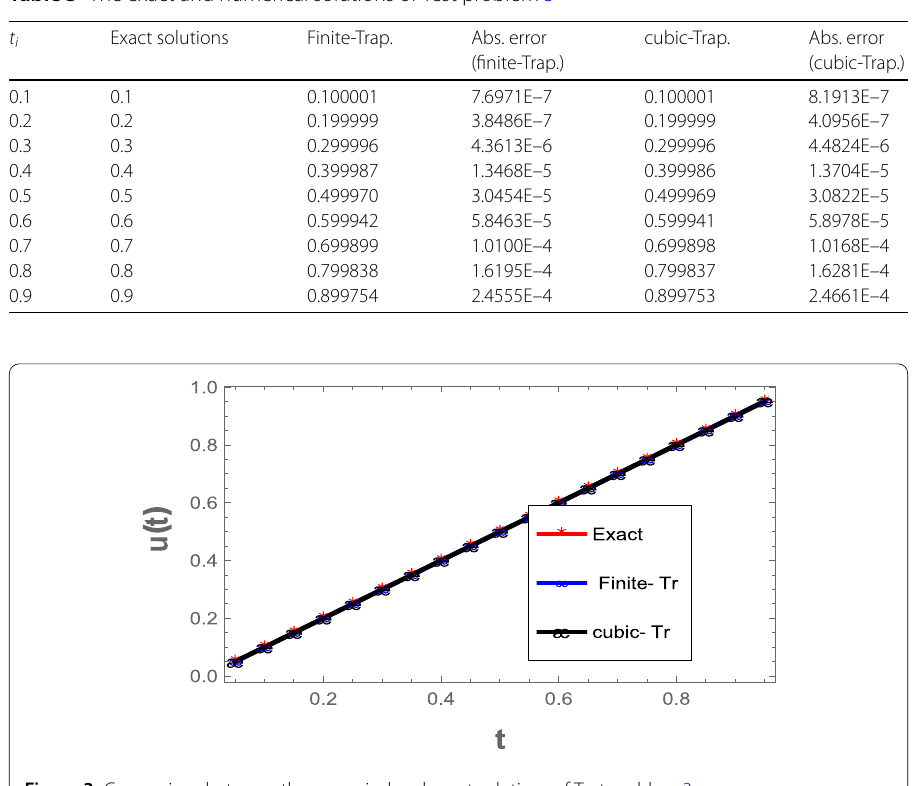
Figure 3 Comparison between the numerical and exact solutions of Test problem